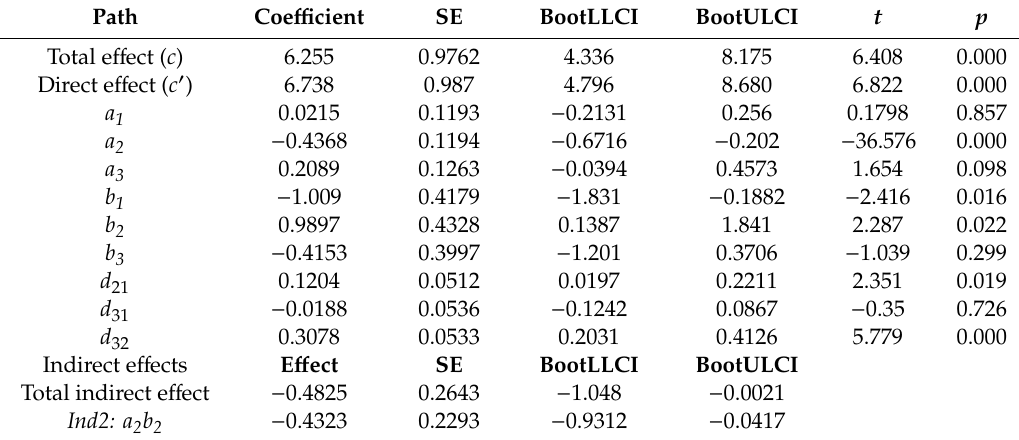
Table 4. Path coe ffi cients; total e ff ect; direct e ff ect; indirect e ff ect; specific indirect e ff ects and 95% bias-corrected confidence interval predicting frequency alcohol scores ( N = 384).